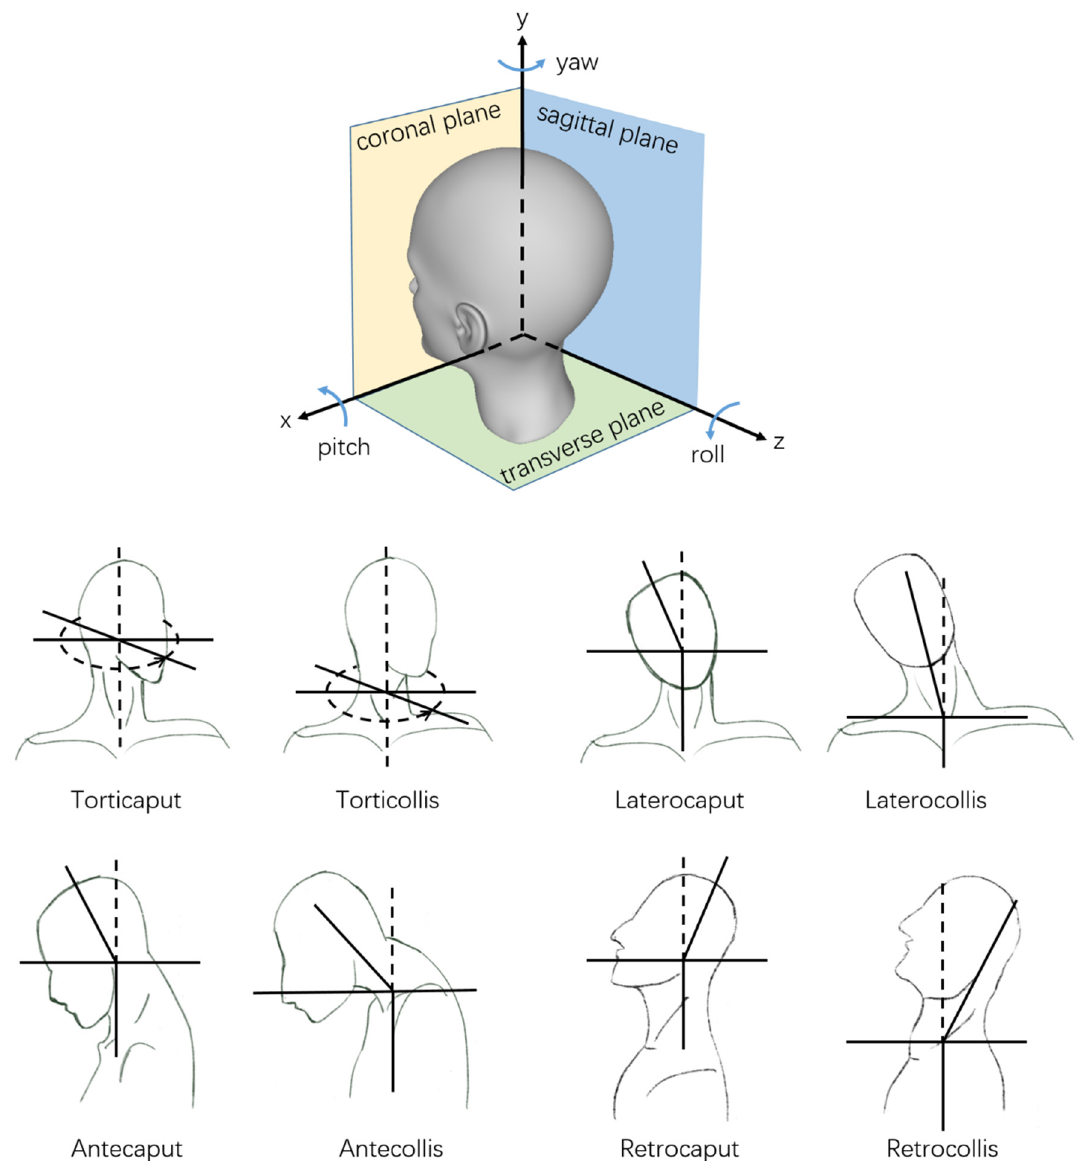
Figure 1. The diagram of abnormal movement patterns of CD.